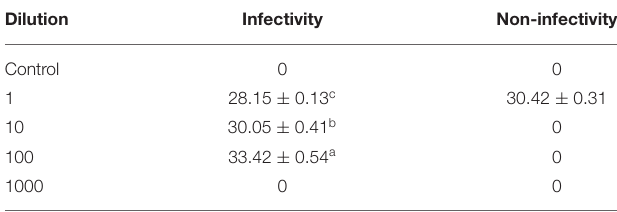
TABLE 4 | Effectiveness of different virus dilution